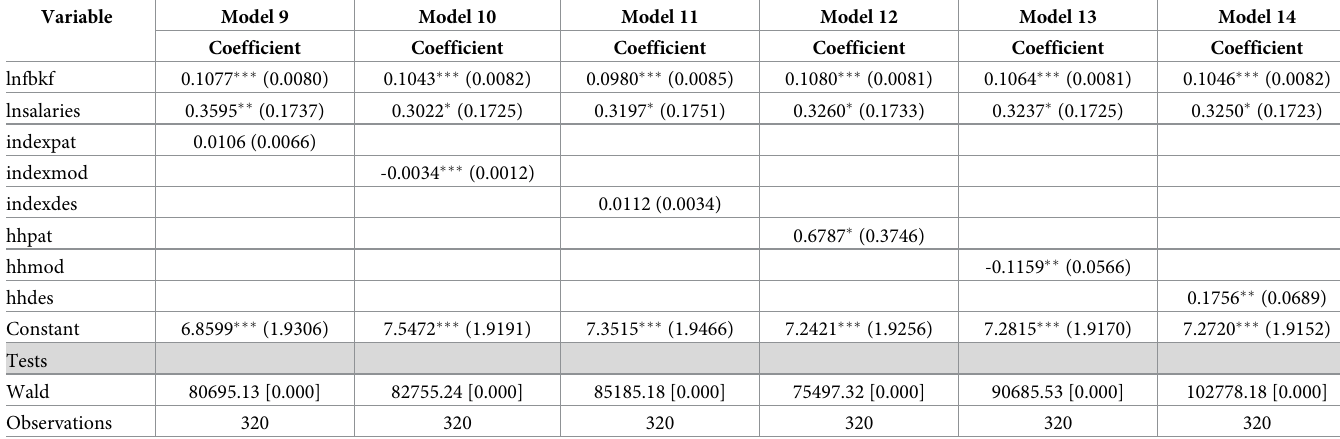
Table 7. Fixed effects estimates with PCSE heteroskedasticity